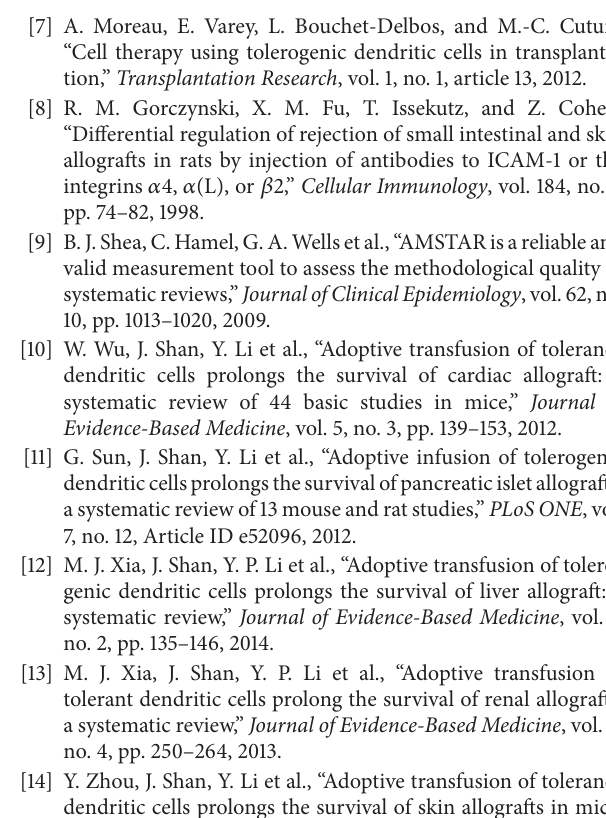
no. 2009CB522401 and by the Natural Science Foundation of China (NSFC) nos. 81270552 and